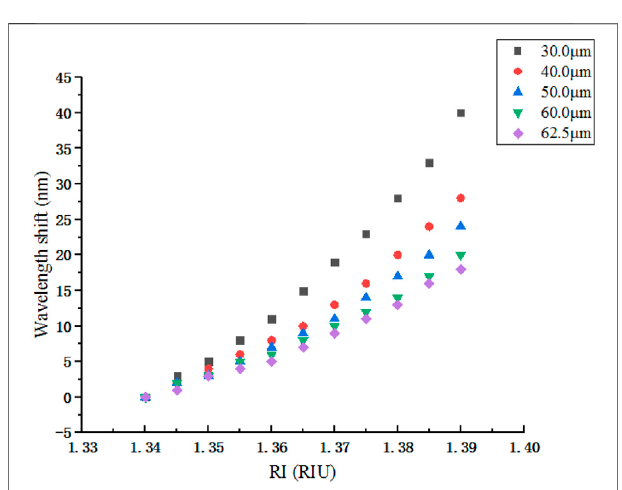
FIGURE 3 | Wavelength shift of D core variation when L 1 (cid:2) 15